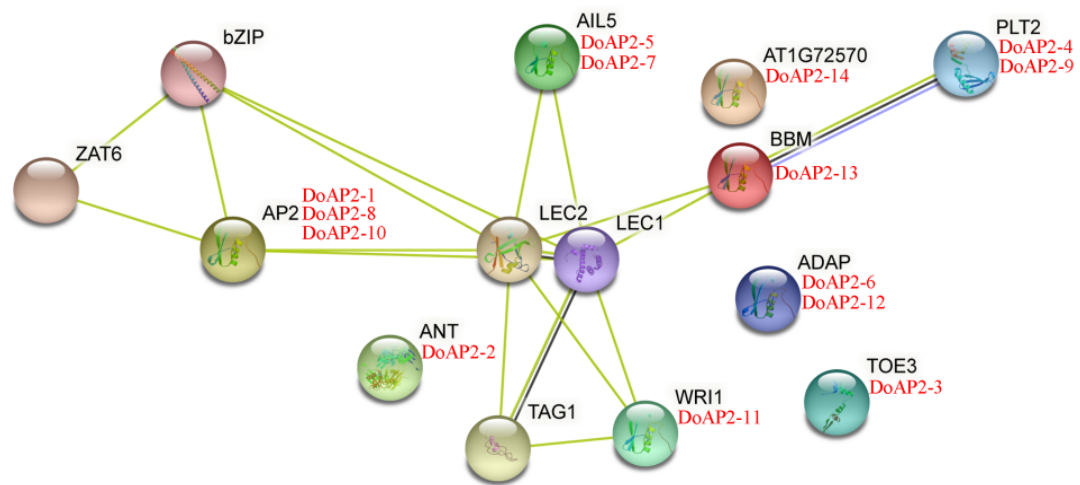
Figure 2. Protein–protein interaction network analysis of DoAP2 proteins using STRING 11. Cyan line represents data from curated databases, green lines indicate gene neighborhoods, and black lines indicate co-expression. Red text = DoAP2s; black text = the proteins in A. thaliana .